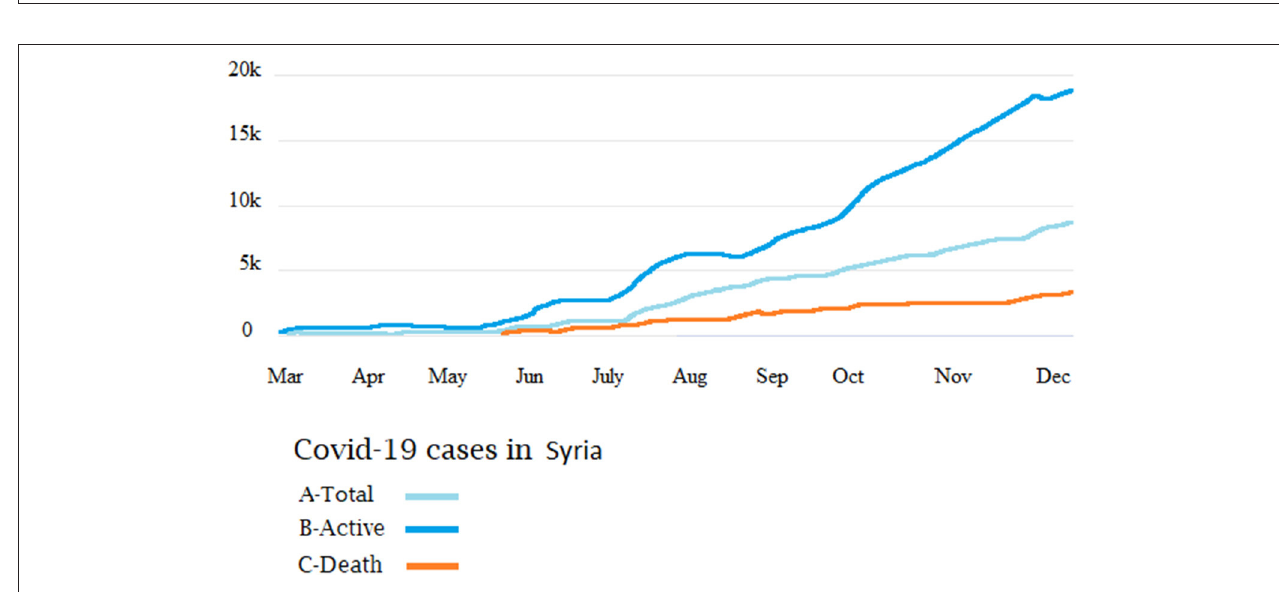
FIGURE 5 | The levels of armed violence in Syria and the spread of COVID-19 during 2020.